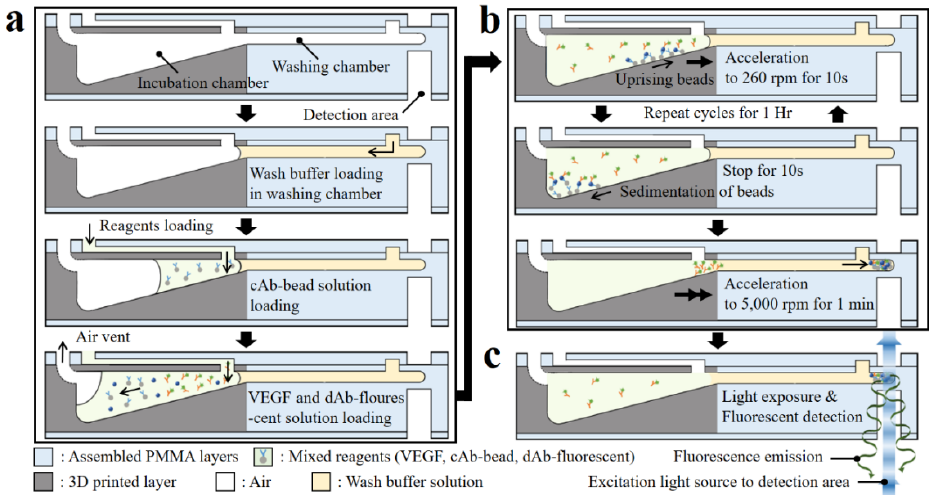
Figure 6. Schematic of sectional view of the microfluidic components highlighting the sequential protocol of the simplified microbead FLISA; the processes indicated are ( a ) loading the wash buffer and reagents, ( b ) incubation, and ( c ) fluorescence detection, respectively.